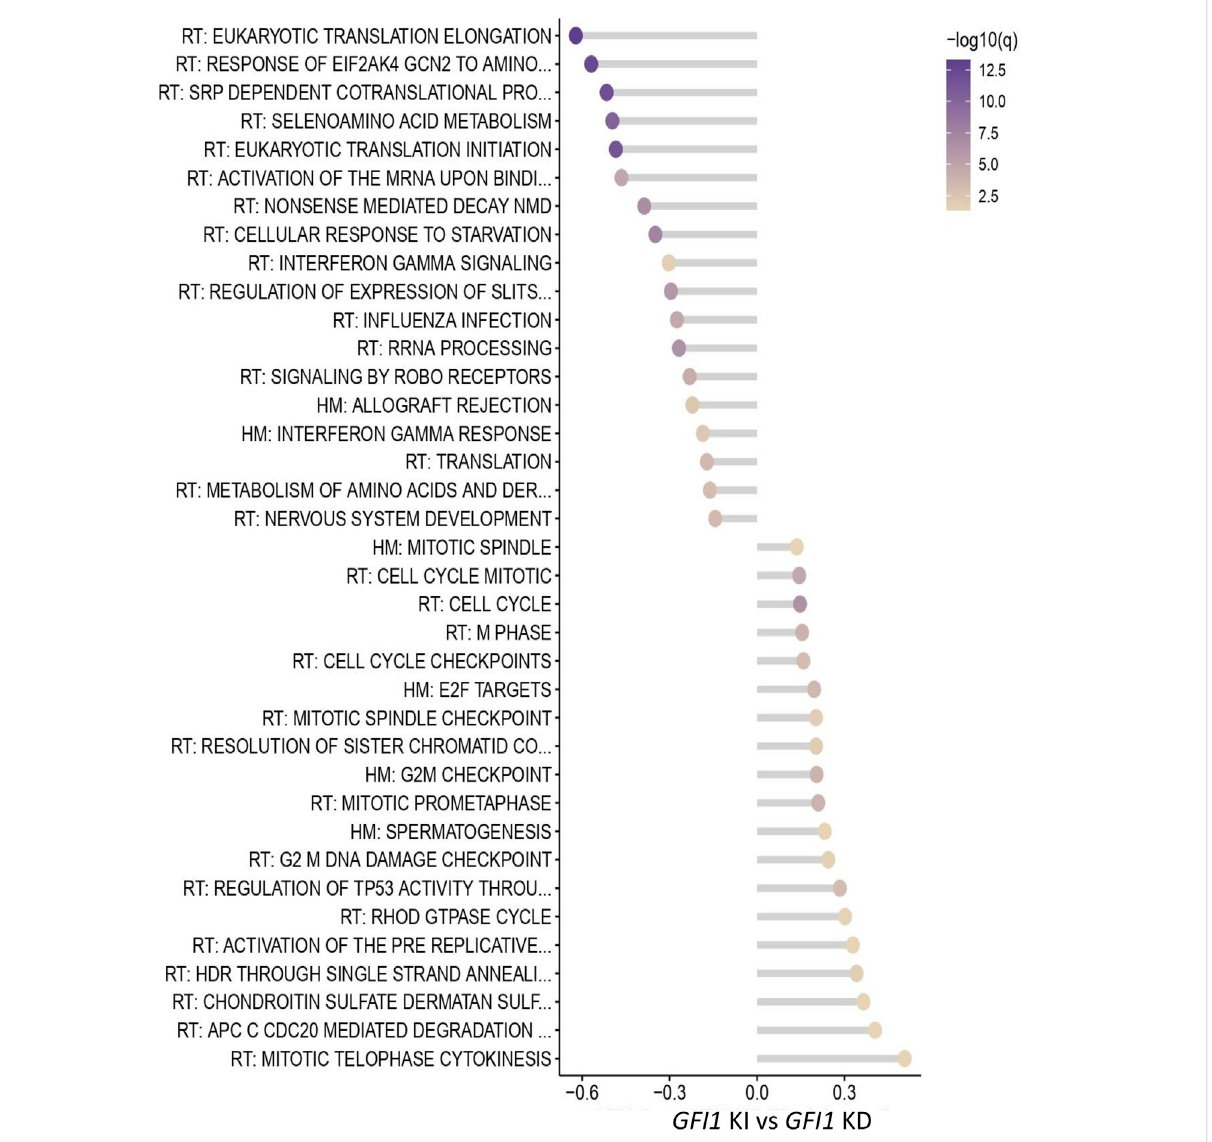
FIGURE 5 RNA-seq data indicate differential regulation of cell-cycle-related pathways in GFI1 -KD HSCs. Pathway analysis from the RNA-seq data shows signi fi cantly altered pathways in GFI1 -KD HSCs in comparison with GFI1 -KI HSCs.